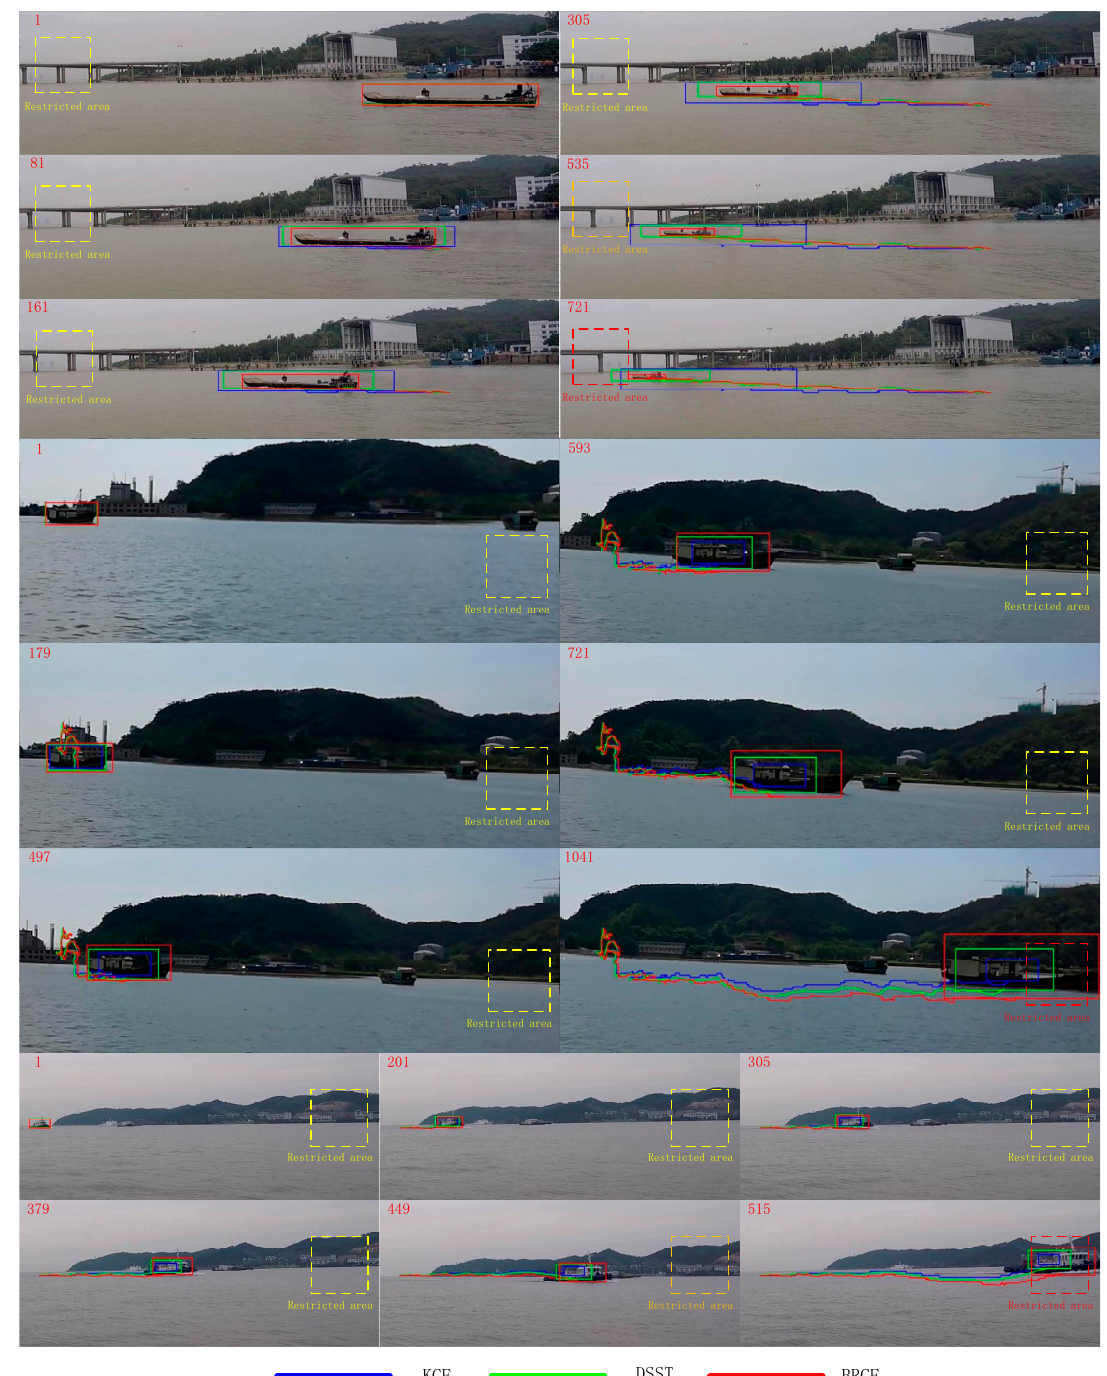
Figure 12. The detection of abnormal events on the sea by the three tracking methods. When the ships sailing near the preset restricted area, the smart ocean system will give an alarm. The color of the dashed rectangle reflects the distance between the moving ship and the restricted area.